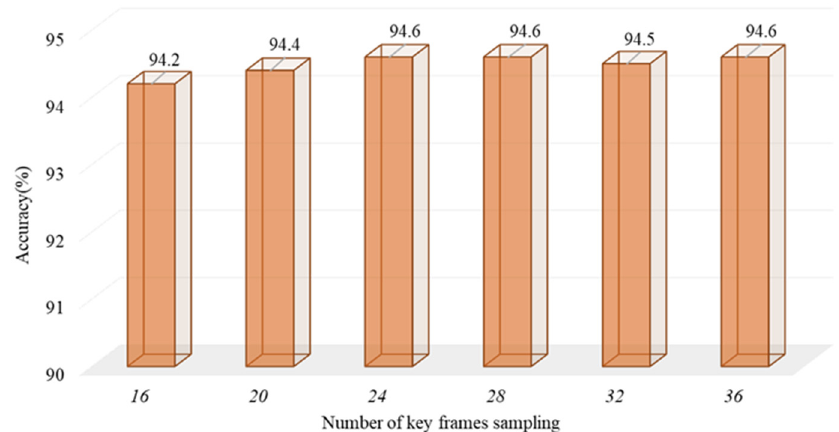
Figure 12. Effects of key-frames ( k = 16, 20, 24, 28, 32, and 36) selection on recognition performance using UTD-MHAD dataset with SSIM metric.